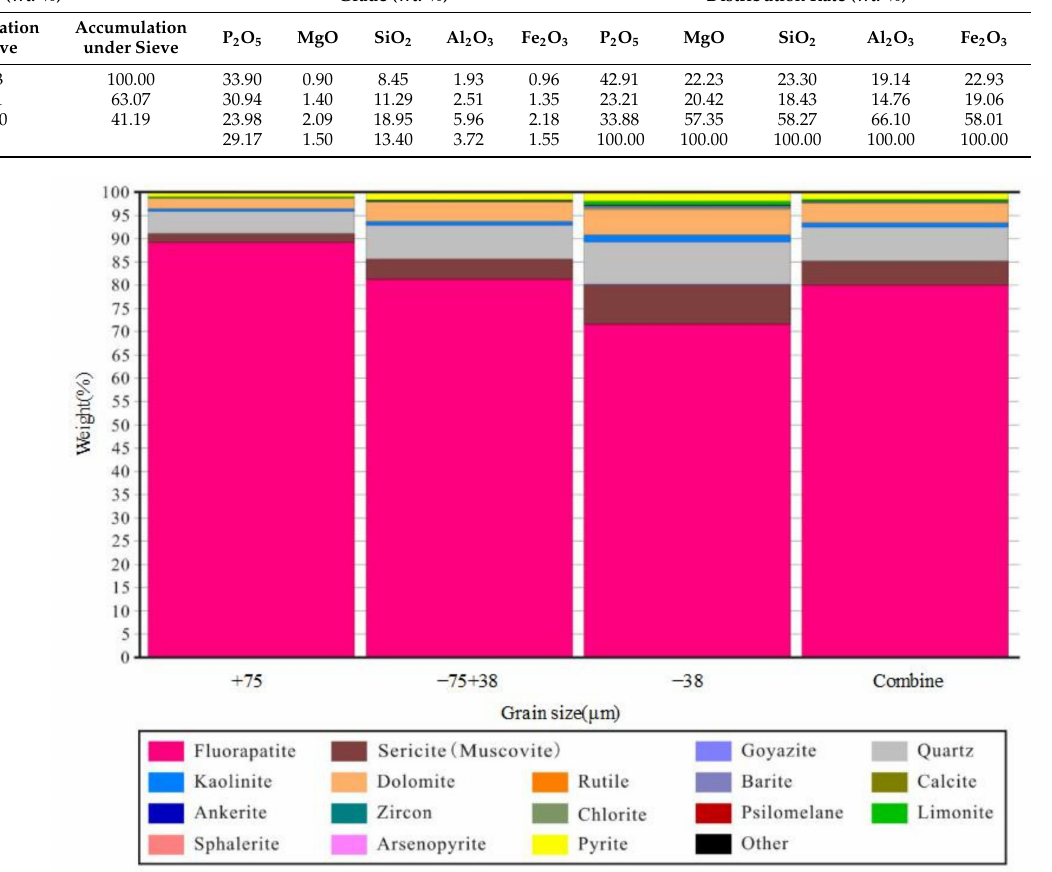
Table 3. Chemical composition and distribution rate of raw ore products with different grain sizes. Yield (wt. %) Grade (wt. %) Distribution Rate (wt. %)